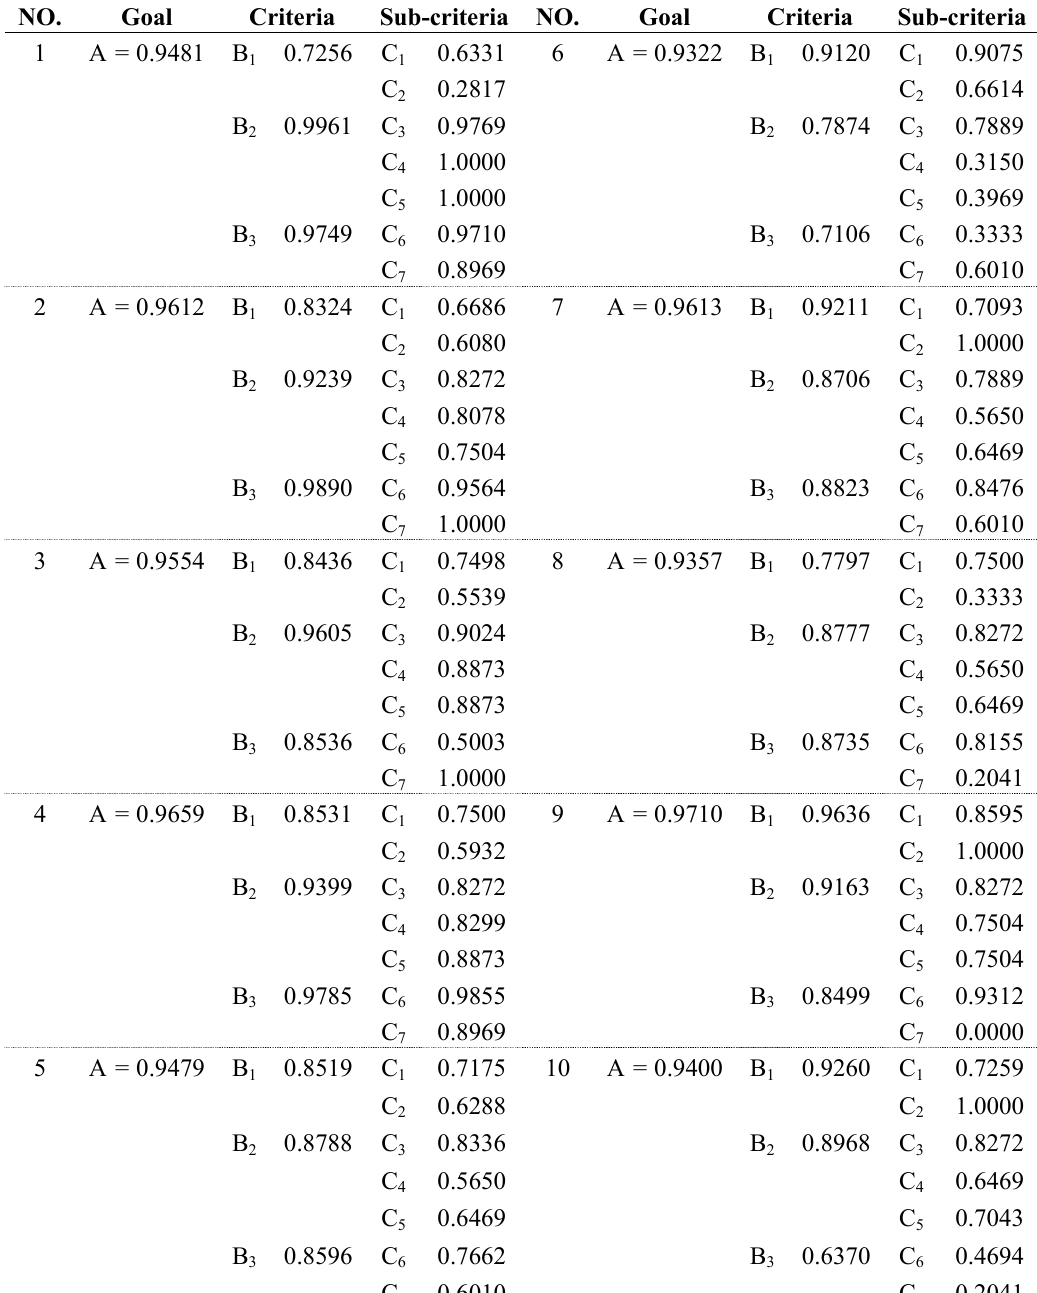
Table 4. Results of risk assessment of chemical enterprises in Songmu Island Chemical Industrial